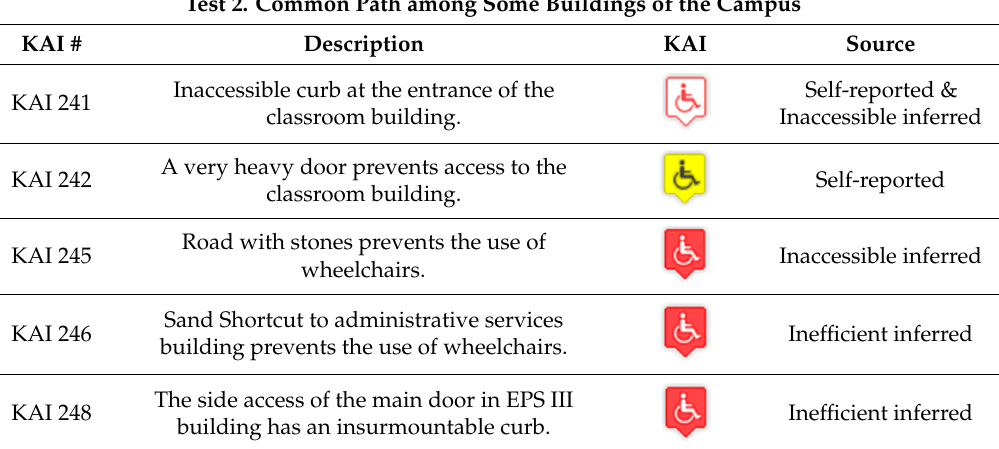
Table 4. Different KAIs obtained in the validation process along some common